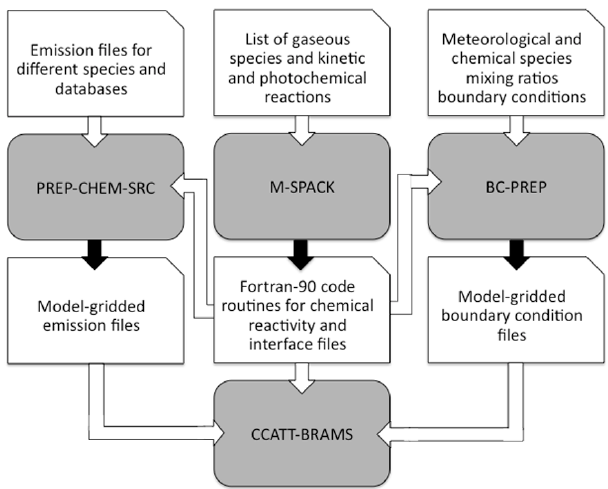
Fig. 2. Schematic of the CCATT-BRAMS system. The gray blocks and the black arrows indicate the codes that make up the CCATT- BRAMS System and their outputs, respectively. The white blocks indicate either the input files for the preprocessing (first line) or the preprocessing outputs (third line), which are also input files for preprocessing emissions and boundary conditions and routines for composing the CCATT-BRAMS